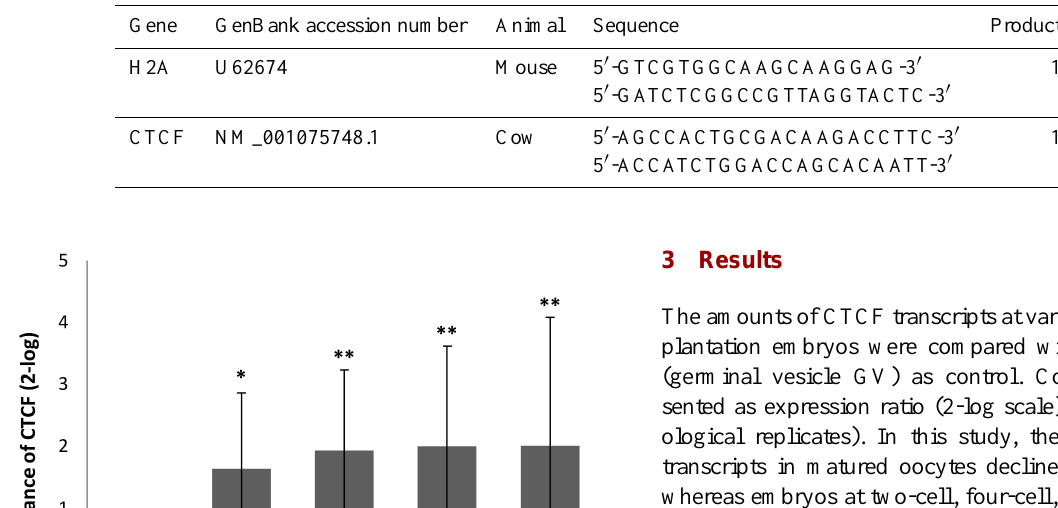
Table 1. Primers used for realtime PCR.